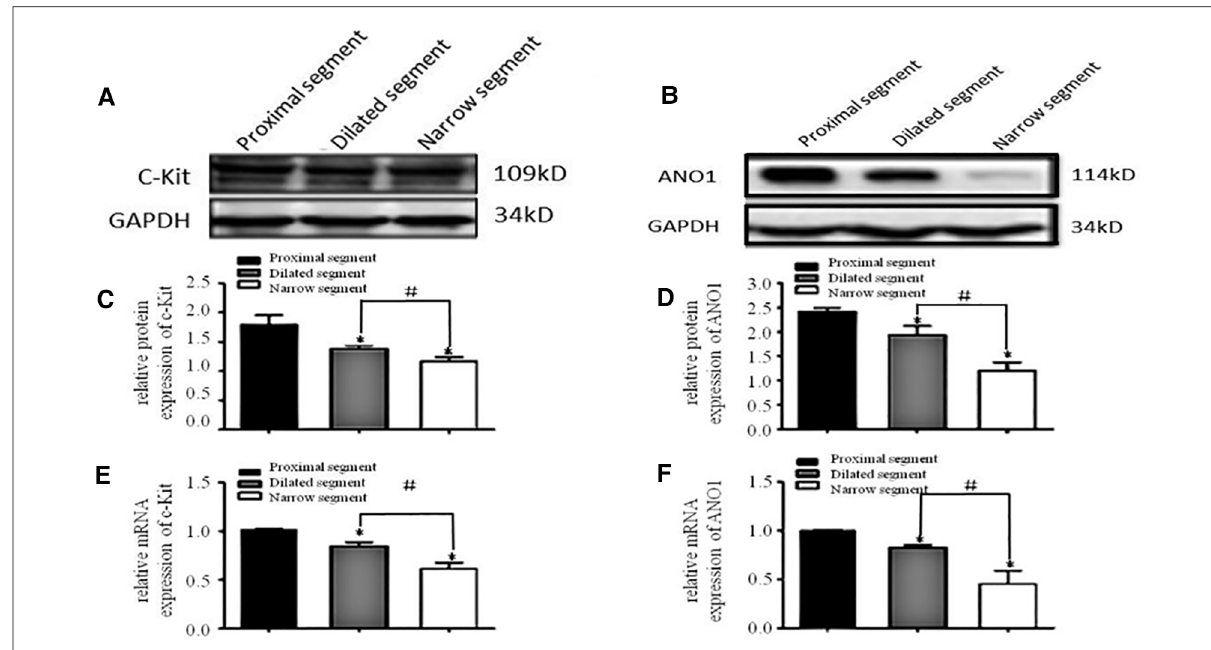
FIGURE 1 mRNA and protein expressions of c-Kit and ANO1. ( A,B ) Electrophoresis identi fi cation. ( C,D ) Signi fi cant difference in the relative expression of the proteins in all the three segments (narrow, dilated, and proximal) of the colon. ( E,F ): mRNA expressions of c-Kit and ANO1 in the three segments. * P <0.05 vs. proximal segment; # P <0.05 dilated vs. narrow